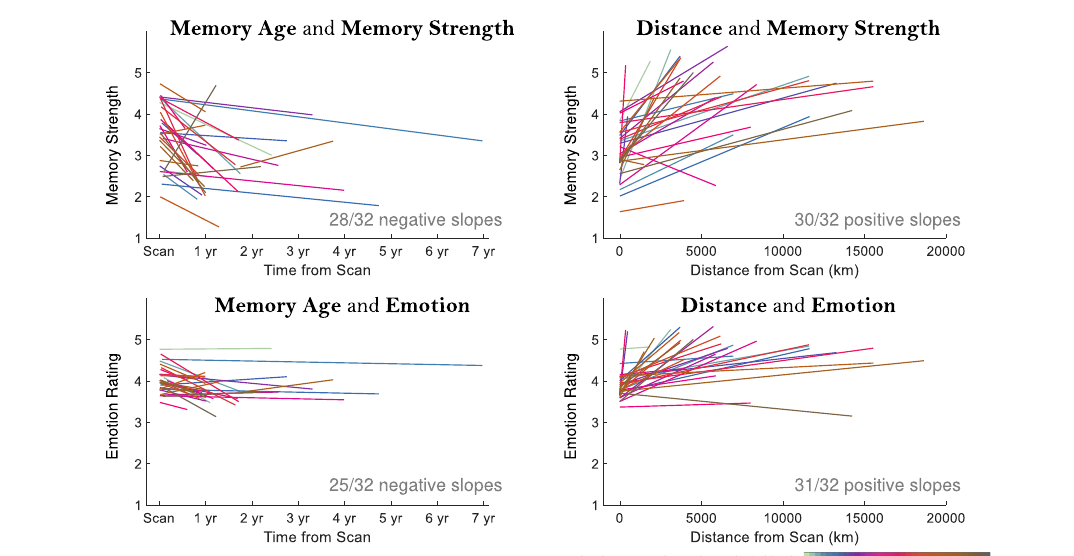
memory for the event. Activation for viewing one ’ s own videos coincides with regions frequently observed in autobiographical memory studies, including hip- pocampus (Hipp.), medial parietal cortex (mPC), medial temporal lobe (MTL), ventromedial prefrontal cortex (vmPFC), lateral prefrontal cortex (lPFC), lateral parietal cortex (lPC), and inferotemporal cortex